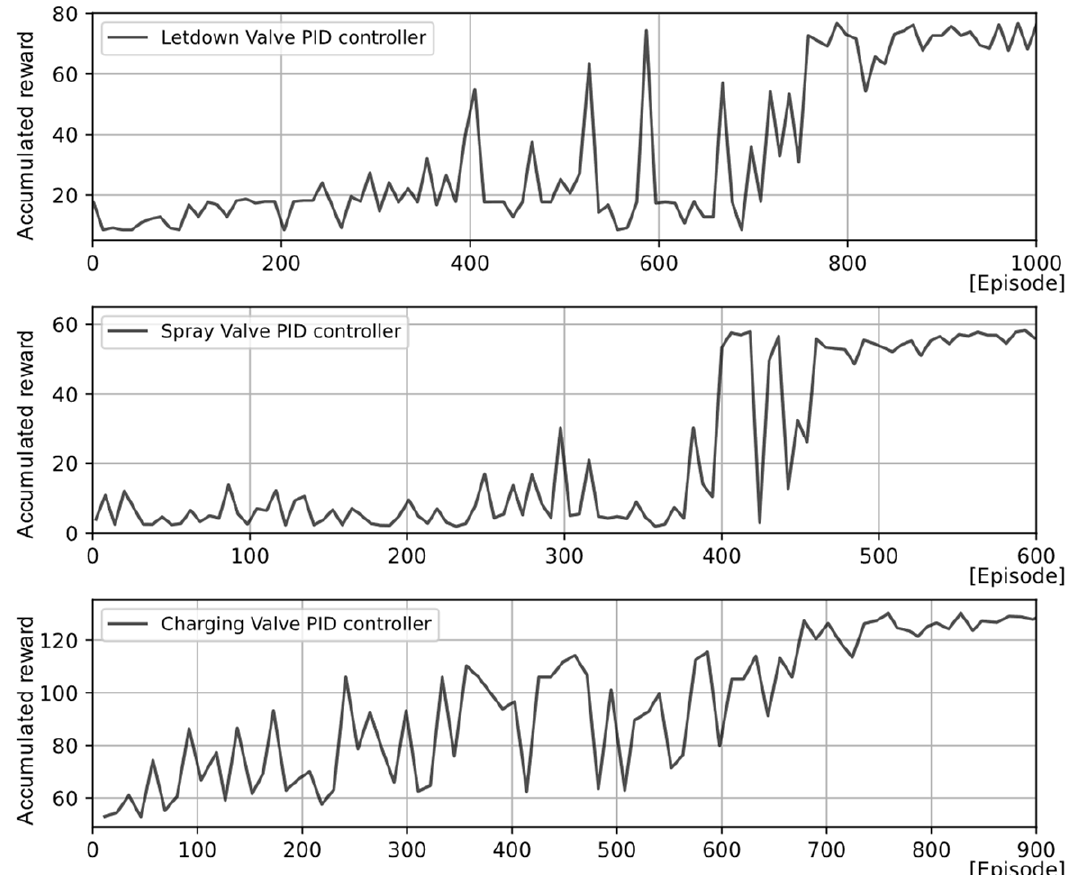
Figure 18. Reward per episode.